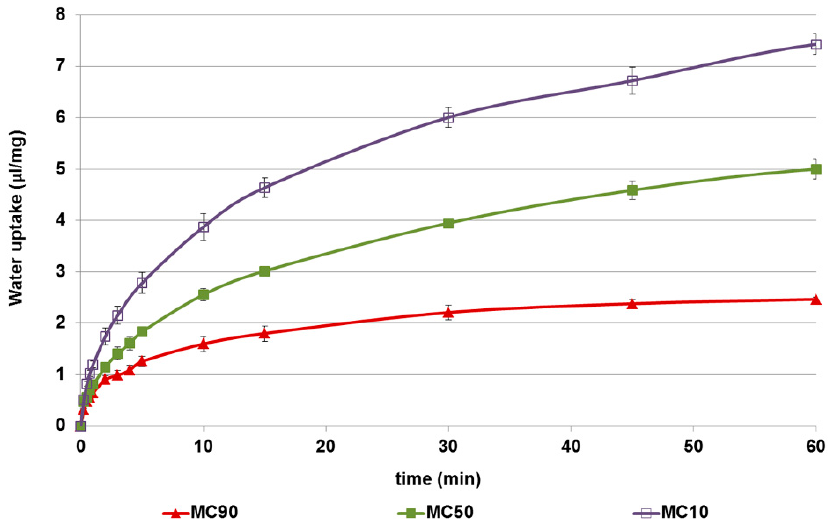
Figure 4. The water uptake capacity ( µ L/mg) of the microspheres. Data are reported as the mean value of three independent experiments. SD values were ≤ 0.17 of their corresponding means. Table 2. Values of flux (J), T lag and drug permeated for each formulation after 120 min.